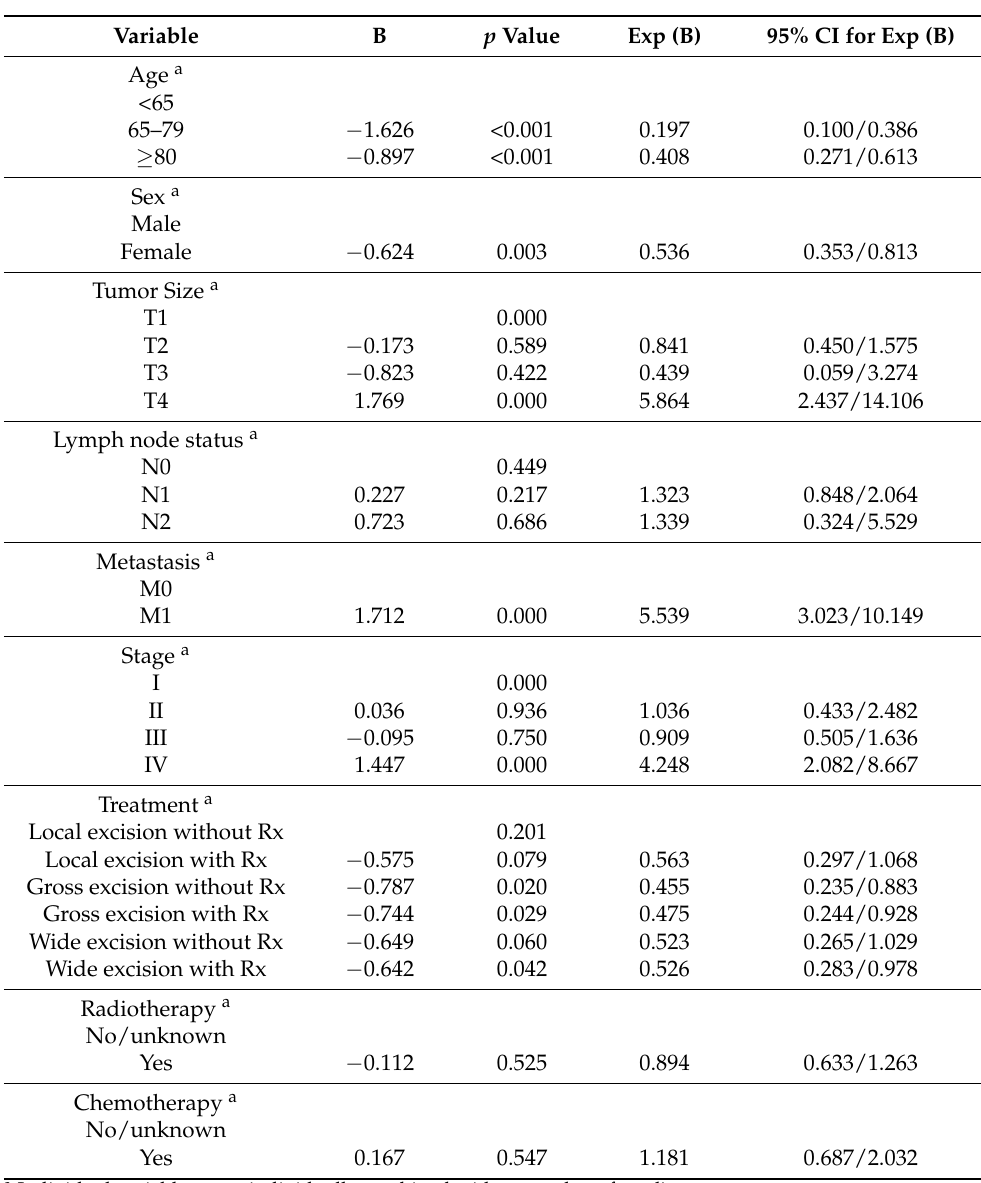
Table 4. Multivariate Cox regression